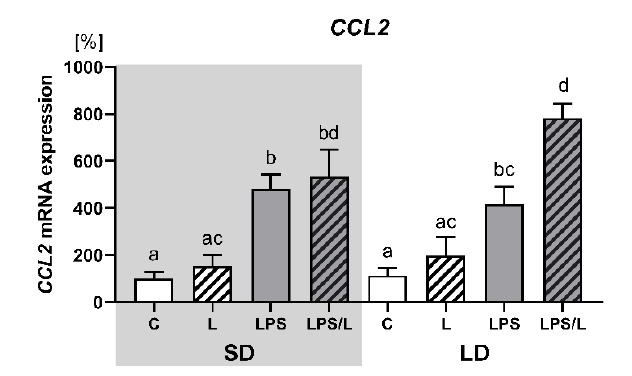
Figure 6. Mean (±SEM) relative CCL2 mRNA expression in the ovine choroid plexus of saline (C, control—white bars), saline–leptin (L, white hatched bars), LPS (grey bars) and LPS–leptin (LPS/L, grey hatched bars) treated ewes, during the short-day (SD, dark background) and the long-day (LD, light background) photoperiod. Different lowercase letters indicate significant differences between all groups at p < 0.05 (two-way ANOVA—Tukey’s post hoc test). The results are presented as percentage values (%), where the SD C group is considered as 100%.